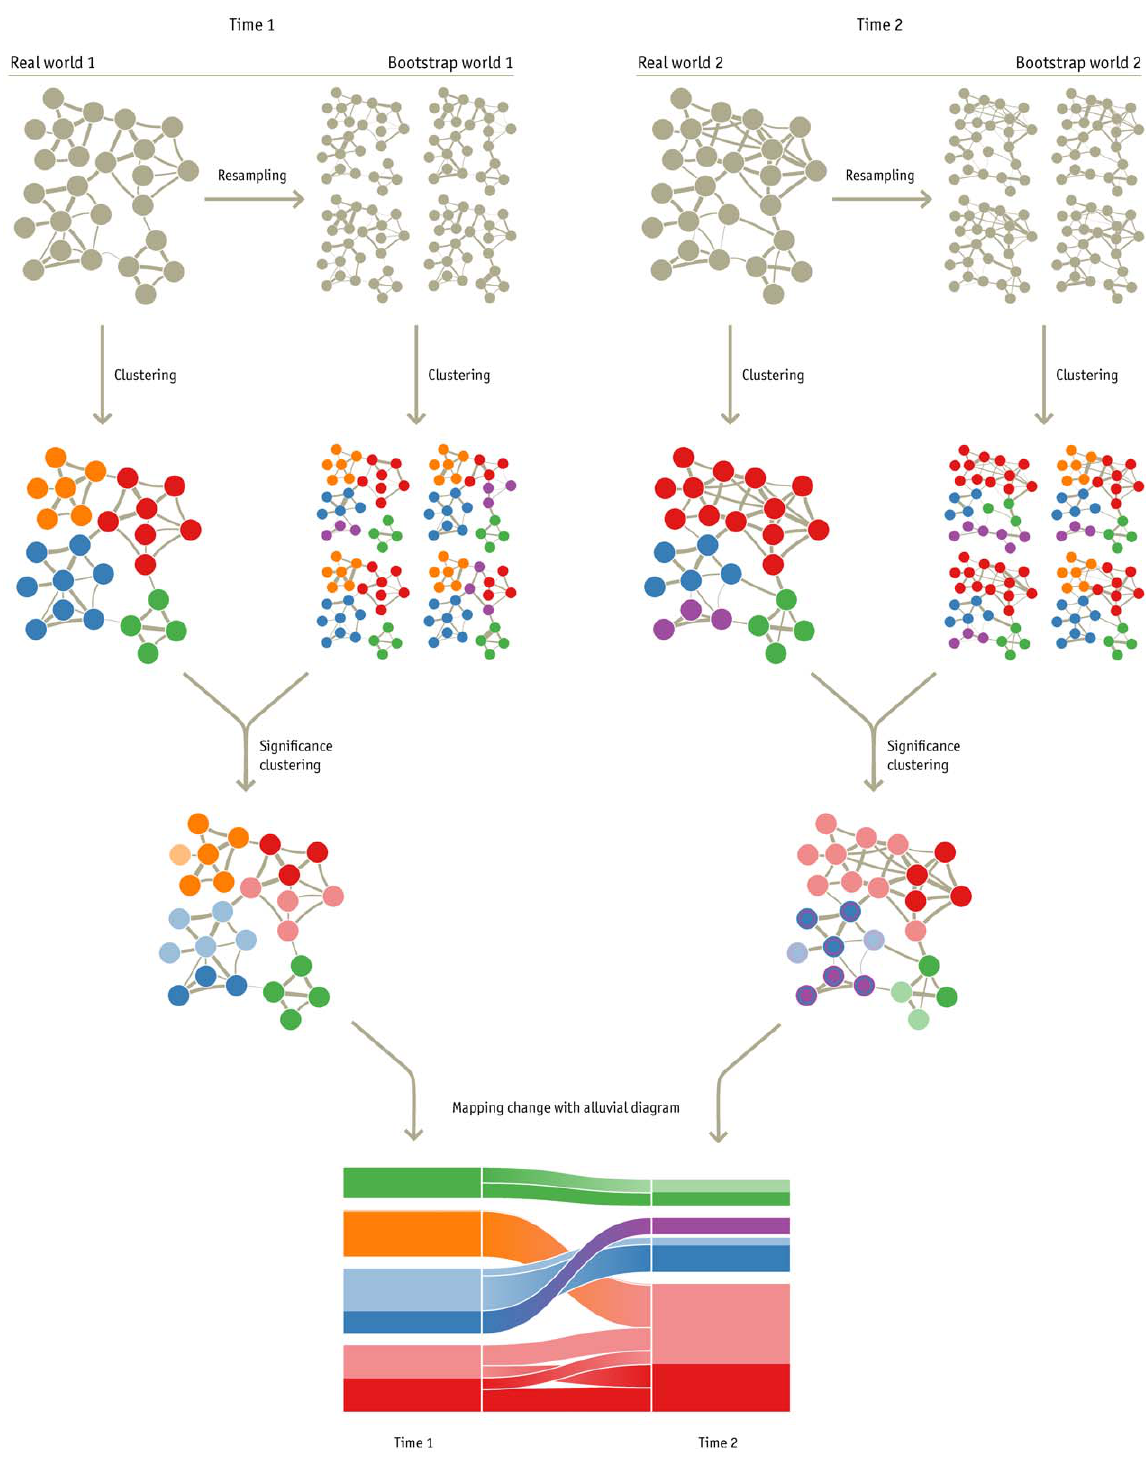
Figure 4. Significance clustering and alluvial diagram for mapping change in large networks. By repeatedly resampling of the weighted links from the original networks, we create ‘‘bootstrap worlds’’ of 1000 resampled networks. By clustering these bootstrap networks, and comparing to the clustering of the original networks, we can estimate the degree of support that the data provide in assigning each node to a cluster. In the bottom networks, the darker colors represent nodes that are clustered together in at least 95% of the 1000 bootstrap networks. The alluvial diagram highlights and summarizes the structural changes between the time 1 and time 2 significance clusters. The height of each block represents the volume of flow through the cluster. The clusters are ordered from bottom to top by their size, with mutually nonsignificant clusters placed together and separated by a third of the standard spacing. The orange module merges with the red module, but the nodes are not clustered together in 95% of the bootstrap networks. The blue module splits, but the significant nodes in the blue and purple modules are clustered together in more than 5% of the bootstrap networks. Neither change is significant.